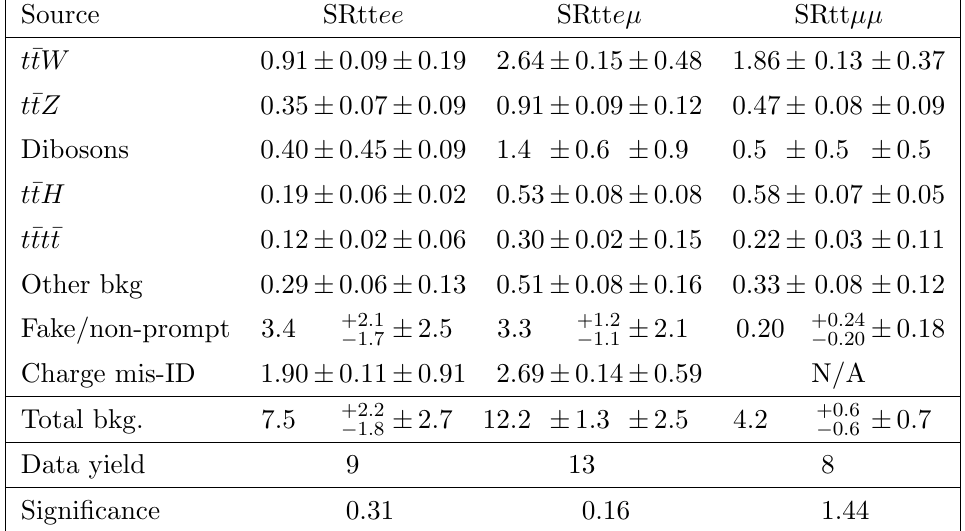
Table 13 . Expected background and observed event yields in the signal regions for the same-sign top-quark pair production search. The ‘Other bkg’ category includes contributions from all rare SM processes listed in section 6. The (cid:12)rst uncertainty is statistical and the second is systematic. The signi(cid:12)cance is the number of standard deviations by which the tt signal plus background hypothesis is preferred to the background-only hypothesis. It is calculated using the same procedure used to calculate the reported